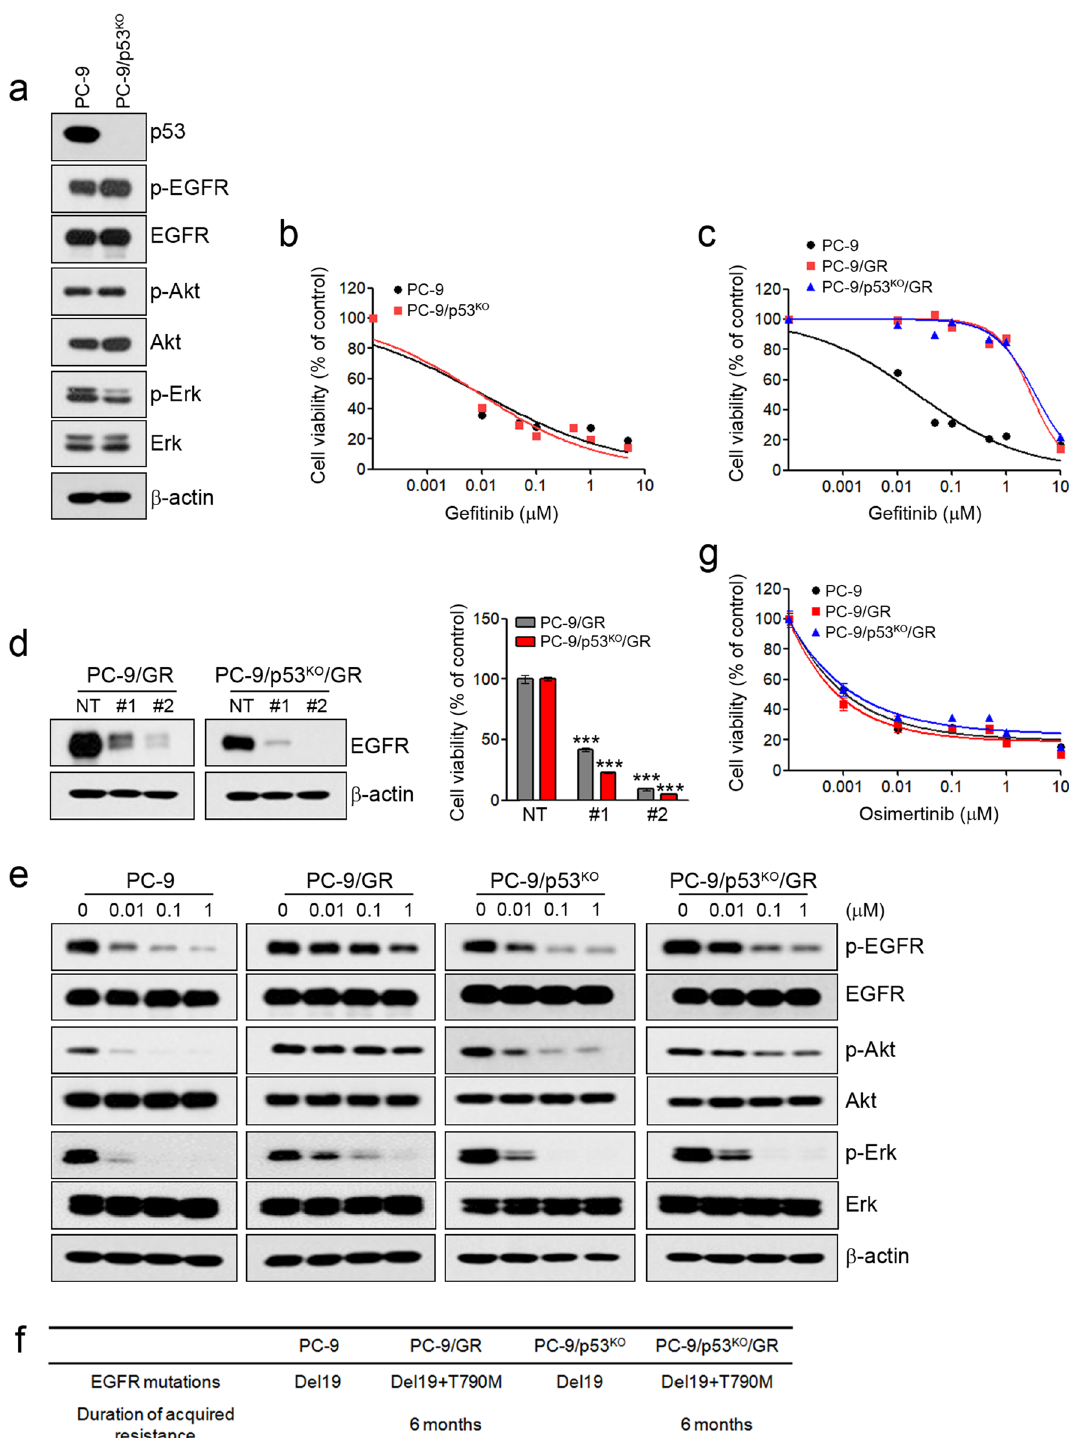
Figure 1. The effects of p53 on sensitivity to EGFR-TKIs in PC-9 cells. Endogenous p53 was silenced using a Crisper/Cas9 knockout system in PC-9 cells. ( a ) The indicated protein levels were analyzed by immunoblotting. ( b , c ) Two gefitinib-resistant cells (PC-9/GR and PC-9/p53 KO /GR) were established as described in the Materials and Methods section. Cells were treated with the indicated doses of gefitinib for 72 h, and cell viability was determined using MTT assays. ( d ) Lentiviral constructs containing the negative control (NT) and EGFR shRNAs were introduced into the indicated cells, and EGFR suppression was confirmed by immunoblotting. Cell viability was measured by cell counting. ( e ) Cells were treated with the indicated doses of gefitinib for 6 h, and EGFR-related signaling proteins were analyzed by immunoblotting. ( f ) Cells were treated with the indicated doses of osimertinib for 72 h, and cell viability was determined using MTT assays. ( g ) EGFR mutations were measured by the PNAClamp™. *** p < 0.0005 compared with negative control